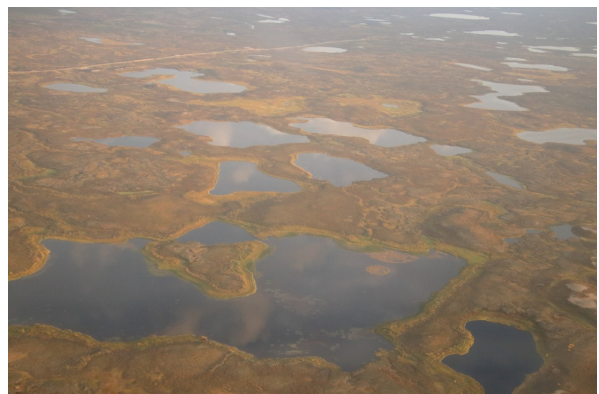
Figure D1. An aerial picture of the tundra around Naryan Mar re- vealing the presence of a huge number of lakes in the region. The picture was provided by Boris D.